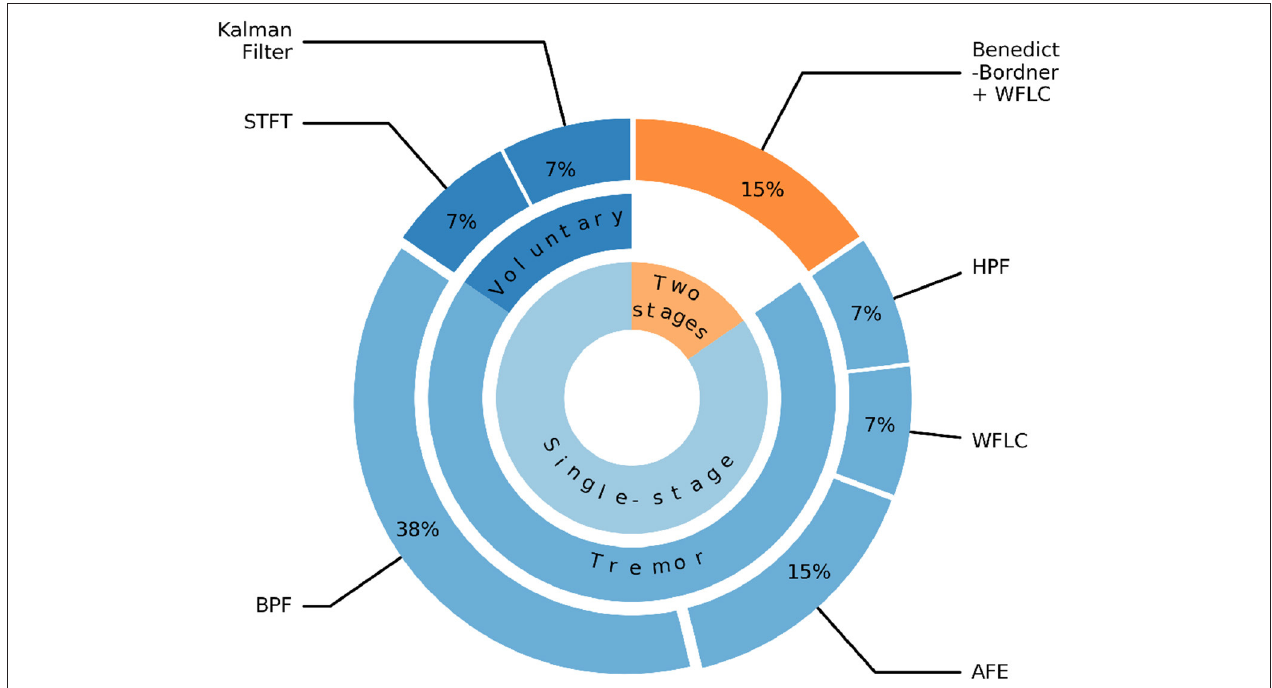
FIGURE 7 | Algorithms for extracting voluntary and tremorous movements. STFT, Short-time Fourier Transform; LPF, Low-pass filter; BPF, Band-pass filter; HPF, High-pass filter; WFLC, Weighted Frequency Fourier Linear Combiner; AFE, Adaptive Frequency